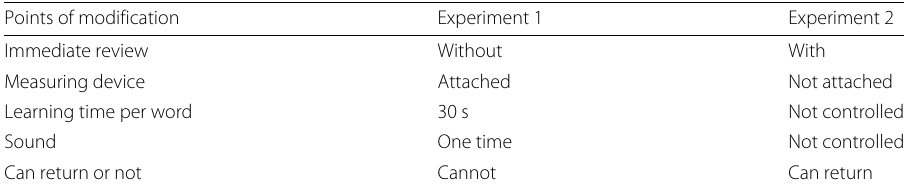
Table 3 Points of modification from experiment 1 Points of